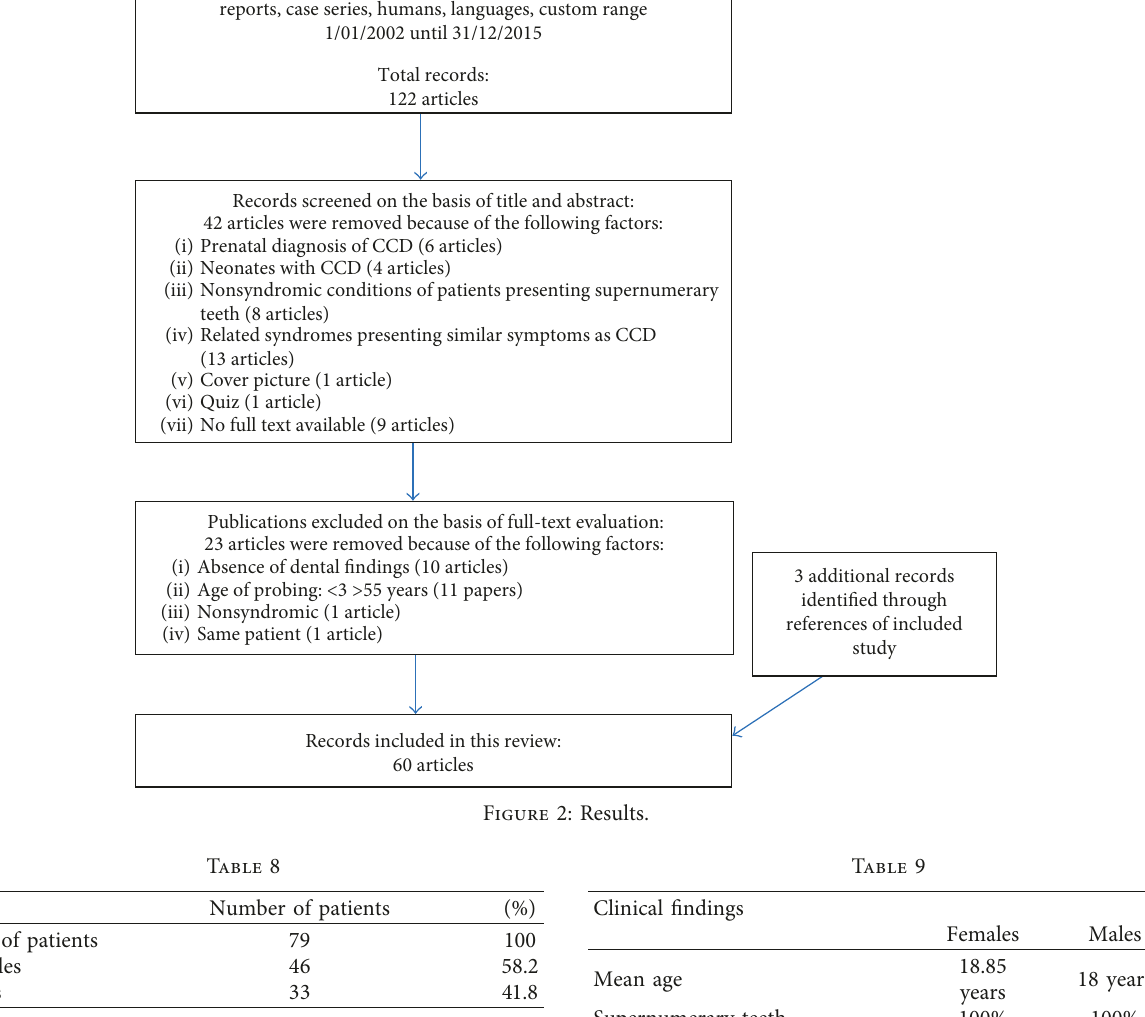
Total of patients